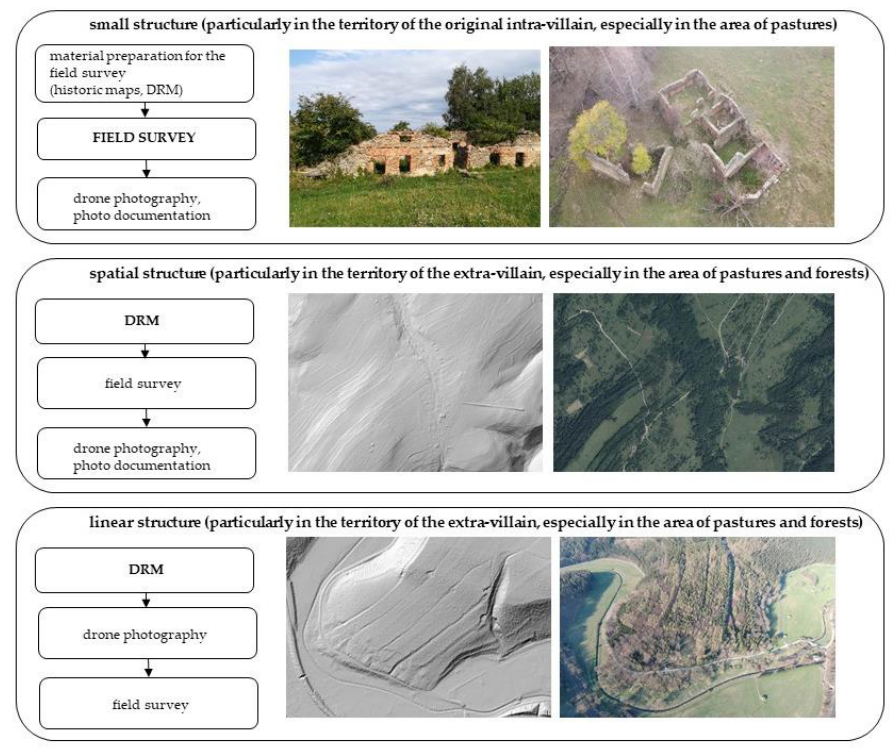
Figure 5. Diagram of the methodical framework for the study of the historic landscape structure in localities of abandoned settlements.